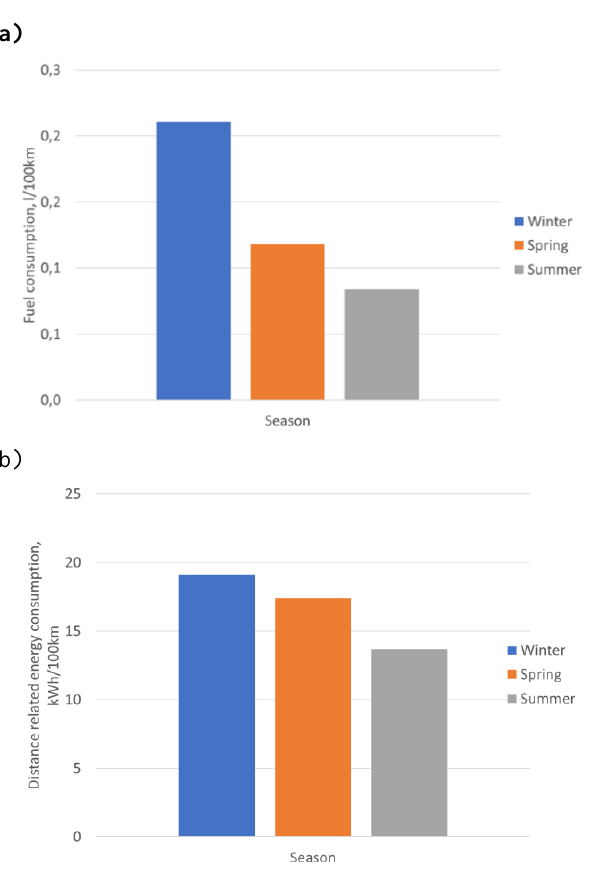
Fig. 2. The mileage consumption of energy carriers in relation to the season in which the measurements were carried out (for the distance traveled once)